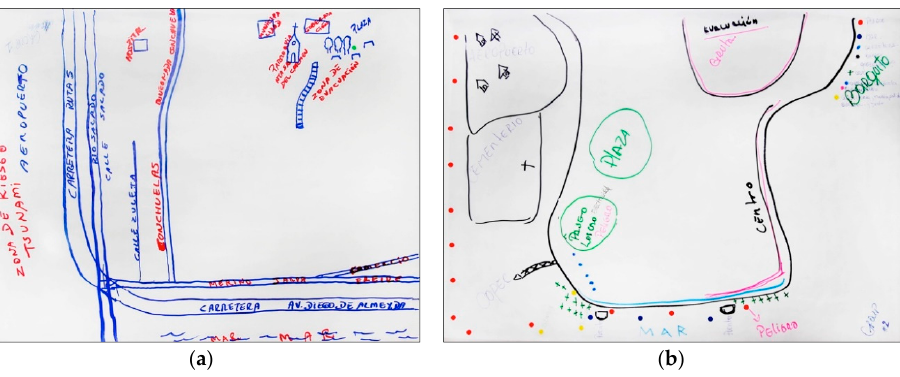
Figure 8. Conceptual Map results: ( a ) Group 1, ( b ) Group 2.